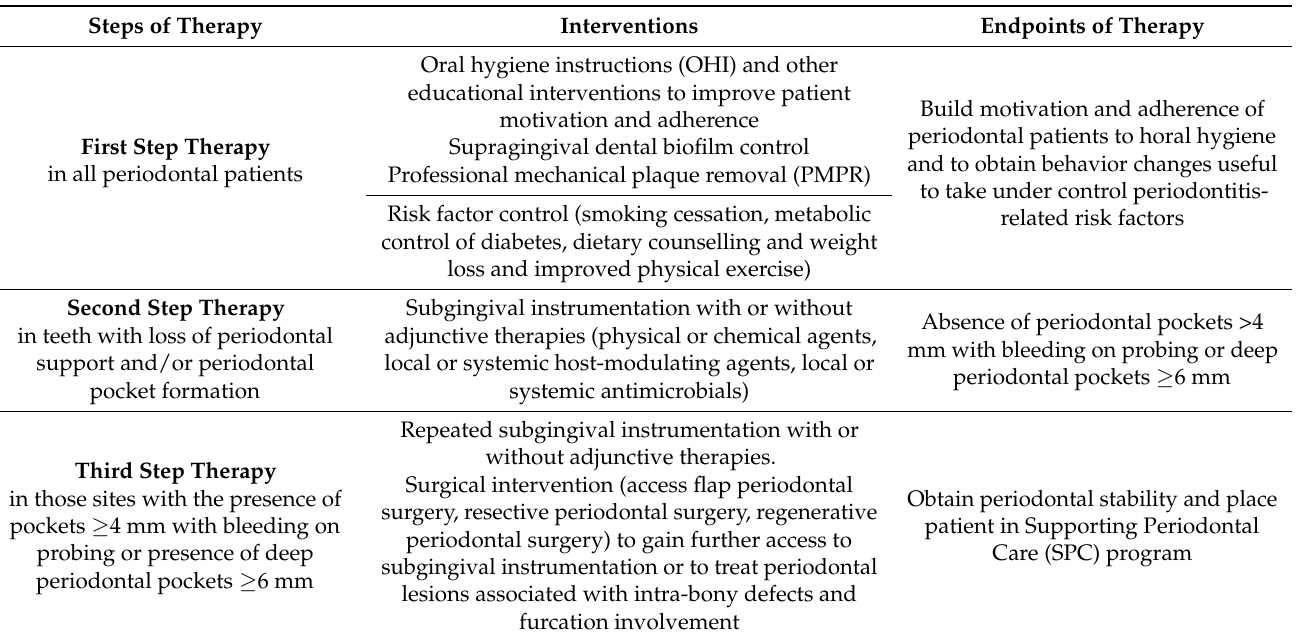
Table 1. This table summarizes the main characteristics of the stepwise approach-based periodontal treatment according to the available evidence in the EFP S3 level clinical practice guideline